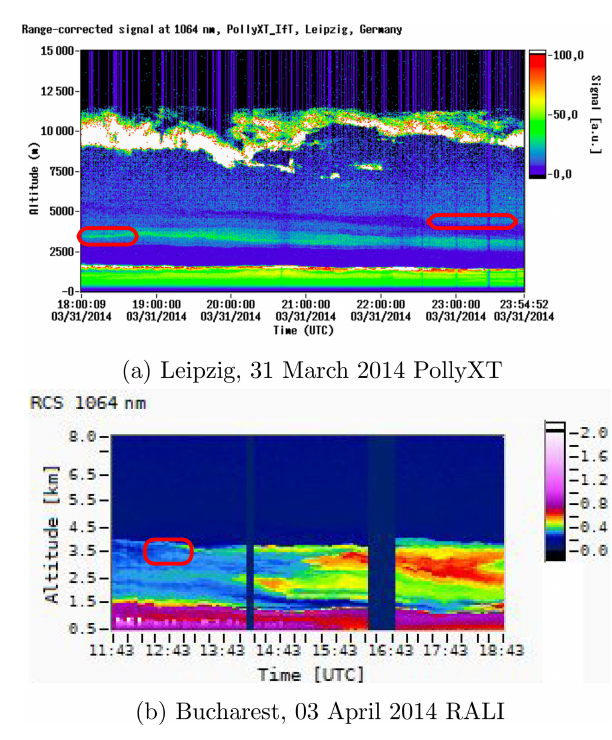
Figure 8. Range-corrected signal at 1064nm for the Leipzig (a) and Bucharest (b) stations. The red boxes represent the identified